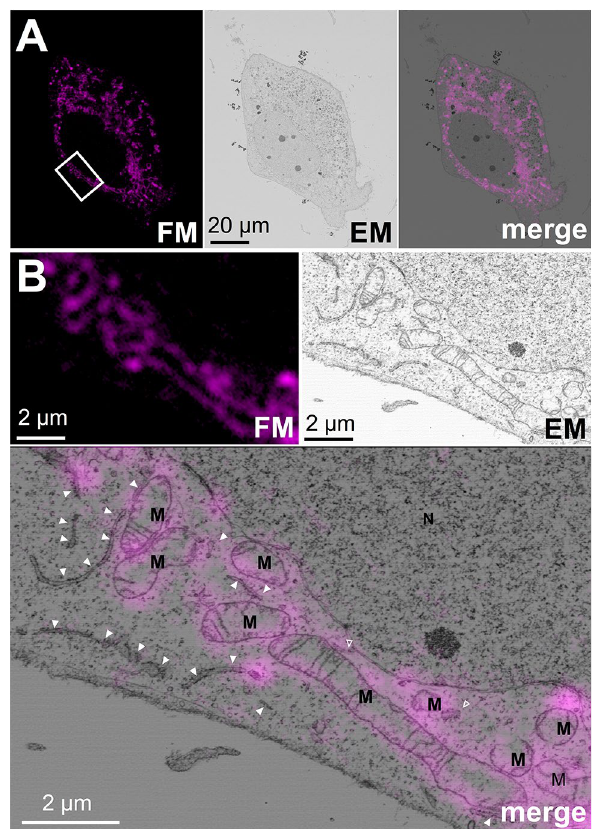
Figure 5. In-resin CLEM of mitochondria of Epon-embedded cells was performed using mtActA-mTurbo. Thin sections (100 nm) of Epon-embedded cells expressing mtActA-mTurbo (magenta pseudo color) were prepared. Fluorescent images ( FM ) and electron microscopic images ( EM ) were obtained as described in Fig. 3. The “ merge ” is a merged image of the fluorescence ( FM ) and electron microscopic images ( EM ). The images in ( B ) indicate × 12.5 ( FM and EM ) and × 25 ( merge ) magnification of the respective images corresponding to the boxed area in the merge image in ( A ). M mitochondria, N nucleus; arrowheads, endoplasmic